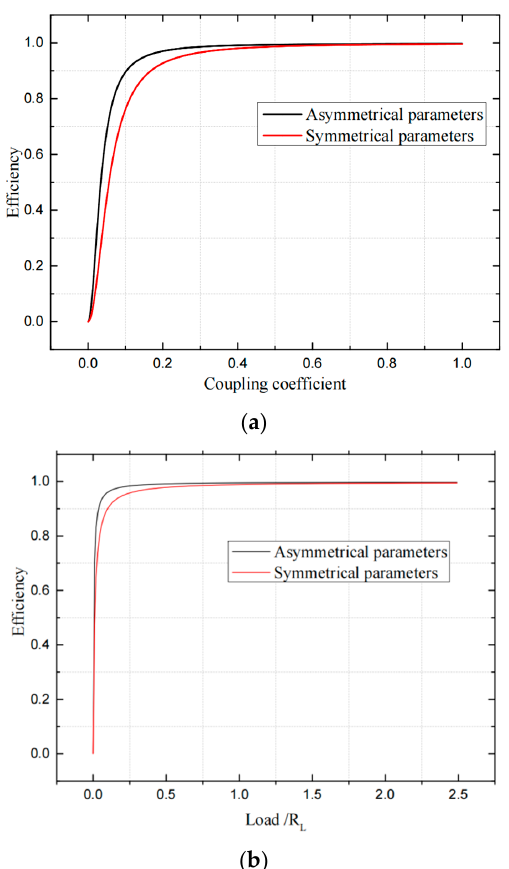
Figure 16. Transmission efficiency characteristic curve of dual-LCC system under different parame- ters: ( a ) transmission efficiency—coupling coefficient, ( b ) transmission